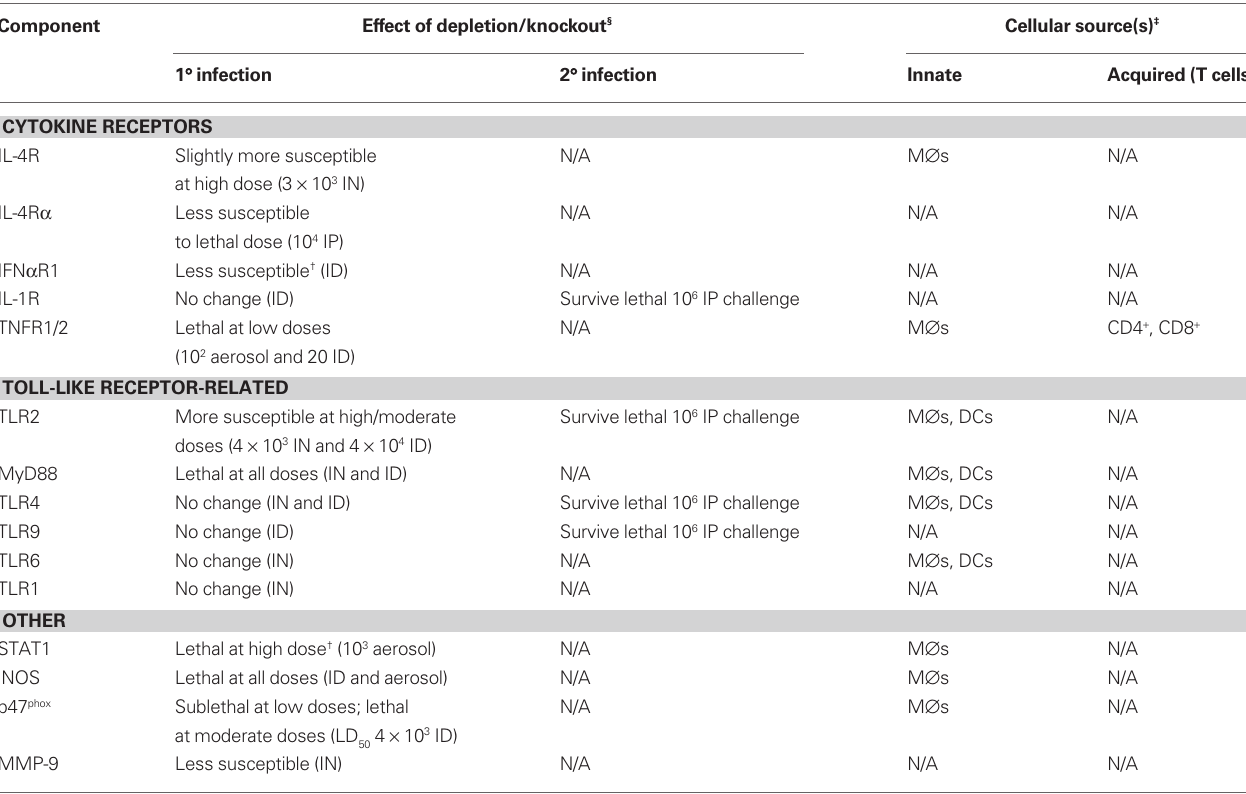
Table 2 | The contribution of cytokine receptors, toll-like receptors, and other effector components of immune responses to in vivo murine infection with Francisella tularensis